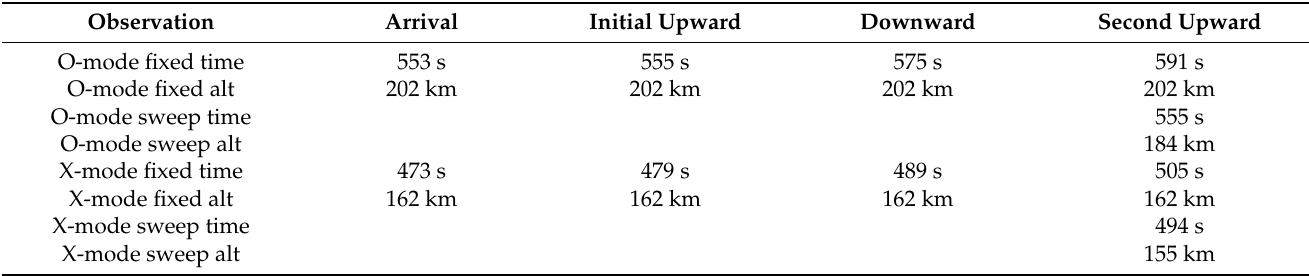
Table 1. Arrival times (seconds from launch) and altitudes (Km) of the first HAAW-induced plasma displacements (arrival), the initial upward HAAW-induced plasma displacement peak (initial up- ward), the downward HAAW-induced plasma displacement peak (downward), and the second upward HAAW-induced plasma displacement peak and associated MCS (second